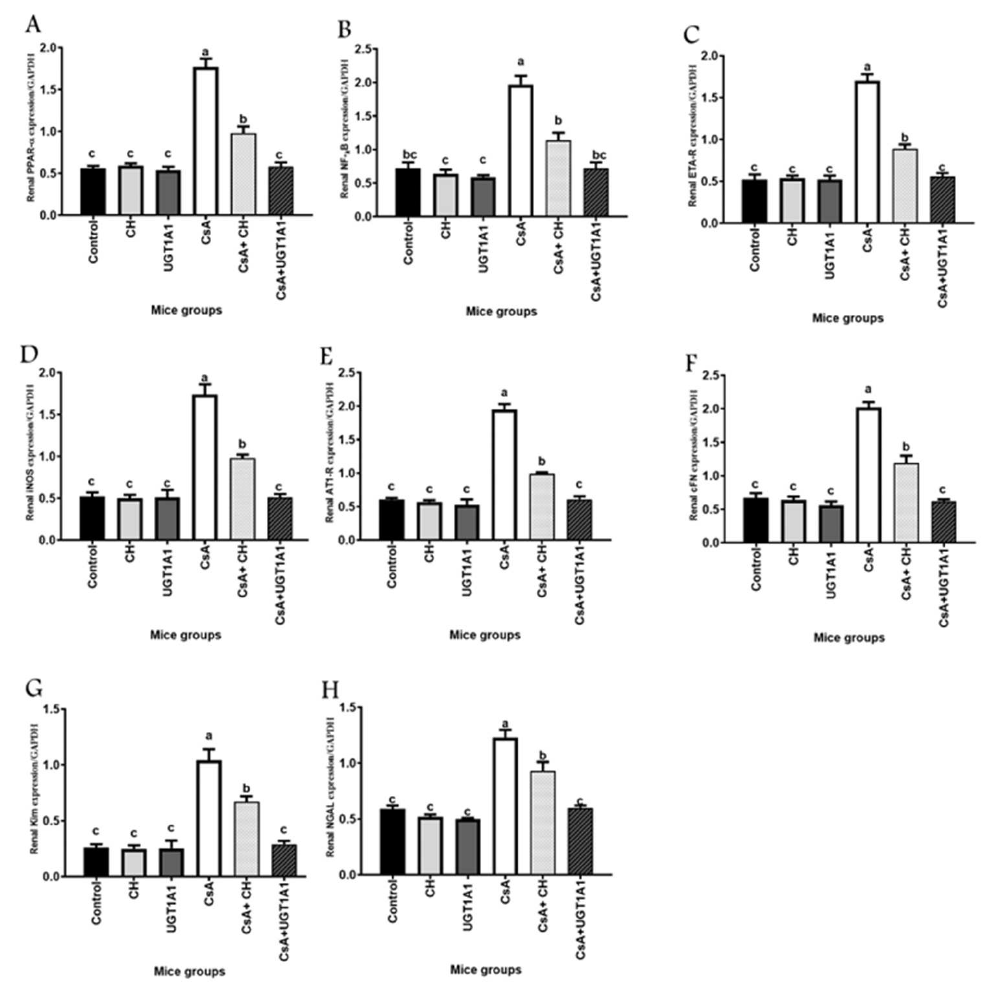
Figure 4. Unconjugated bilirubin, a signaling molecule, activates PPAR- α and regulates NF-kB, ETA-R, iNOS, AT1-R, cFn, Kim-1, and NGAL gene expression in CsA-treated mice: ( A ) peroxisome proliferator-activated receptor alpha (PPAR- α ); ( B ) nuclear factor kappa B (NF-kB); ( C ) endothelin type A-receptor (ETA-R); ( D ) inducible nitric oxide synthase (iNOS); ( E ) angiotensin type1-receptor (AT1-R); ( F ) cellular fibronectin (cFN); ( G ) kidney injury molecule-1 (Kim-1); and ( H ) neutrophil gelatinase-associated lipocalin (NGAL). Values are expressed as mean ± SEM ( n = 8). Means of different letters are statistically different ( p < 0.05). (ANOVA; Duncan’s post hoc